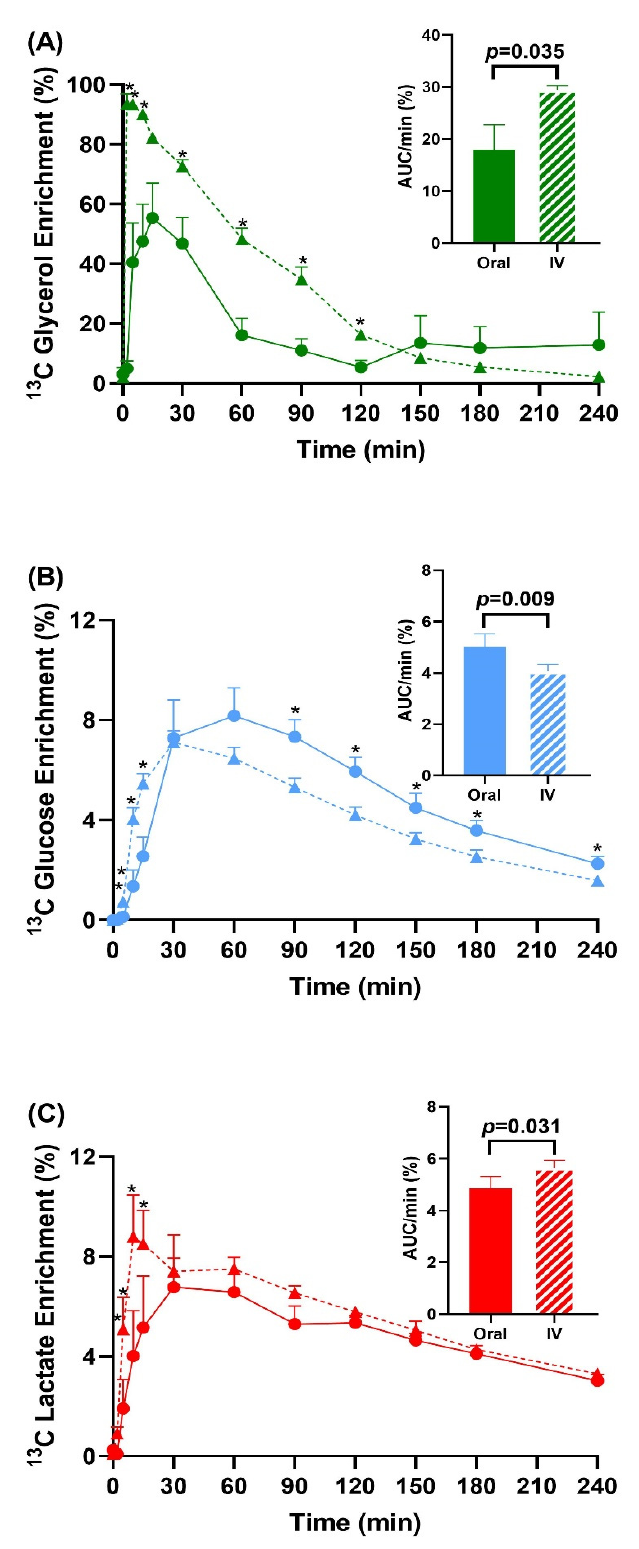
Figure 1. 13 C-enrichment data of glycerol ( A ), glucose ( B ), and lactate ( C ) after oral (solid) and intravenous (dashed, IV) 13 C 3 -glycerol administration. Inset graphs have the area under the curve (AUC) data. * p < 0.05 via paired t-test or Wilcoxon sign-rank test between oral and intravenous administration. n =